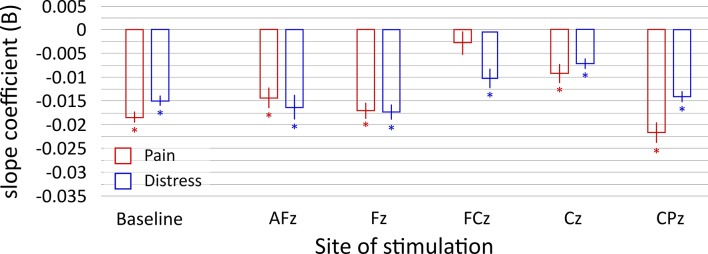
Slope of regression lines for pain and distress ratings, for all stimulation sites and baseline.Asterisks mark significant regressions and error bars represent standard errors.